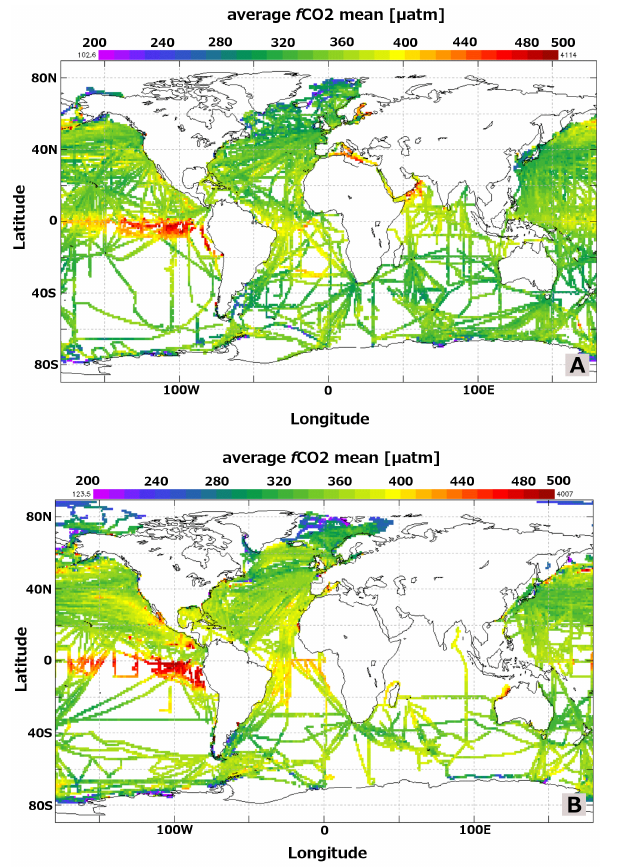
Figure 3. Mean unweighted surface water f CO 2 (µatm) for the years 1970–2002 (a) and 2003–2011 (b) using the SOCATv2 monthly 1 × 1 degree gridded data set (Bakker et al., 2014). The maps were generated by using the online Live Access